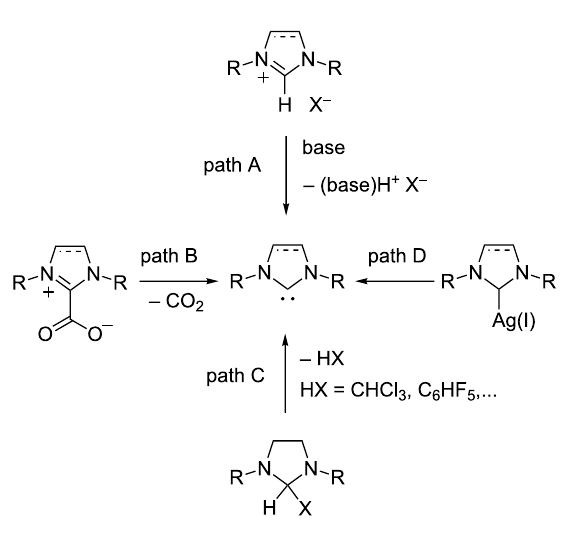
Scheme 1: Various synthetic paths leading to the formation of